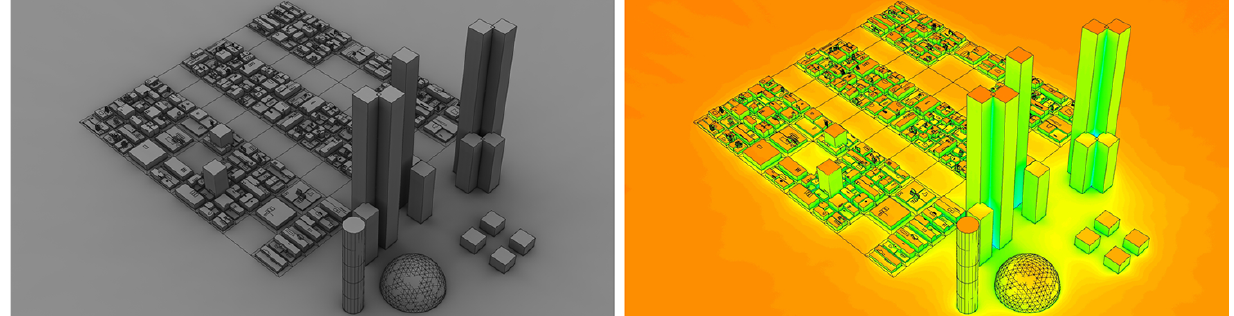
Figure 6. This figure shows screen grabs of a simple precinct model with partially restrictive height limits (low buildings) (left image) with GPU based viewport feedback for sky view factor (urban canyon) of the model on the (right